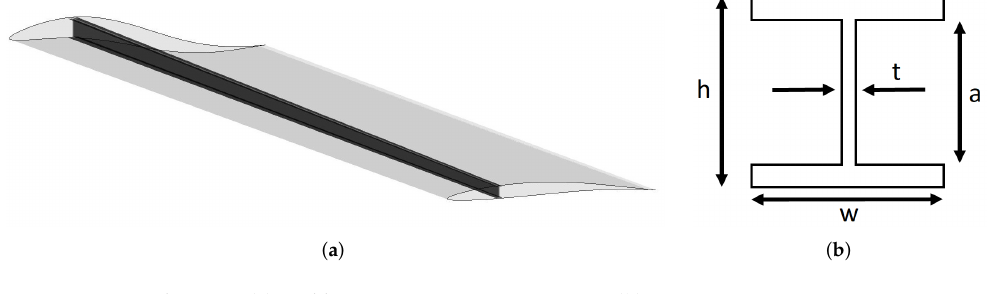
Figure 4. Beam location ( a ) and beam cross-section geometry ( b